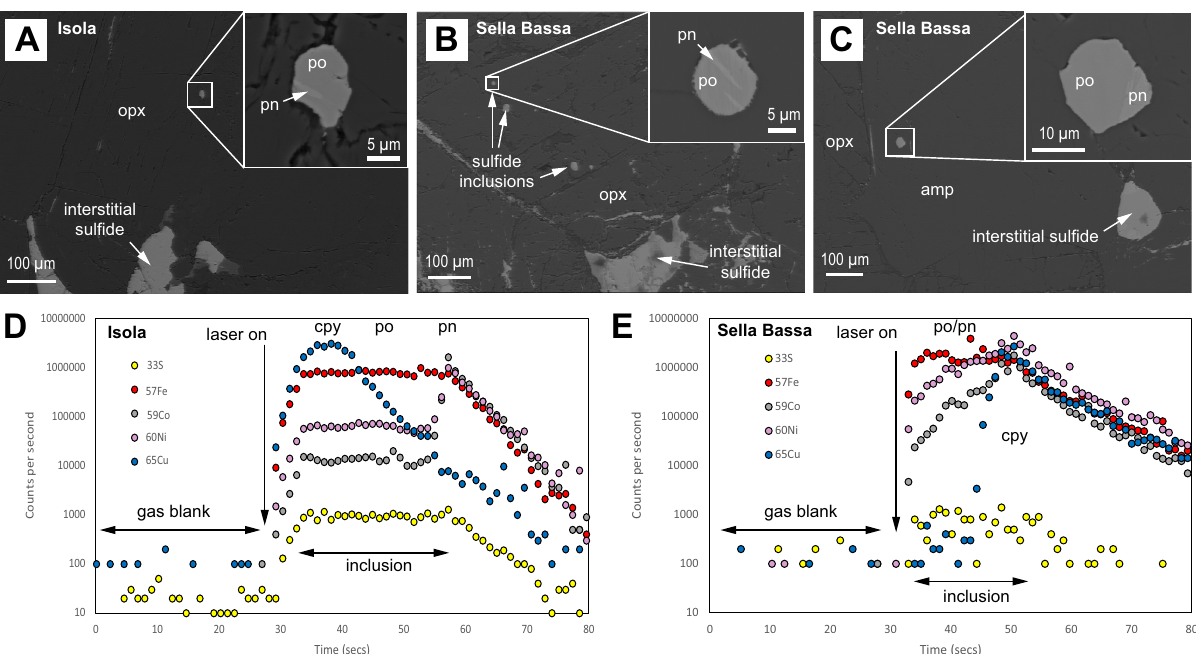
Fig. 3 Sul fi de inclusions in primary silicates from the Isola Sill and Sella Bassa. A Sul fi de inclusion with pyrrhotite (po) and pentlandite (pn) exposed on the cut surface in cumulus orthopyroxene (opx) from Isola; B Sul fi de inclusions with pyrrhotite and pentlandite exposed on the cut surface in cumulus orthopyroxene from Sella Bassa; C Sul fi de inclusion with pyrrhotite and pentlandite exposed on the cut surface in intercumulus amphibole (amp) from Sella Bassa; D , E Examples of time-resolved analysis spectra from LA-ICP-MS analyses of inclusions from the Isola Sill and Sella Bassa, respectively, showing separate peaks in Cu, and Ni + Co, representing spatially separated chalcopyrite (cpy) and pentlandite grains within